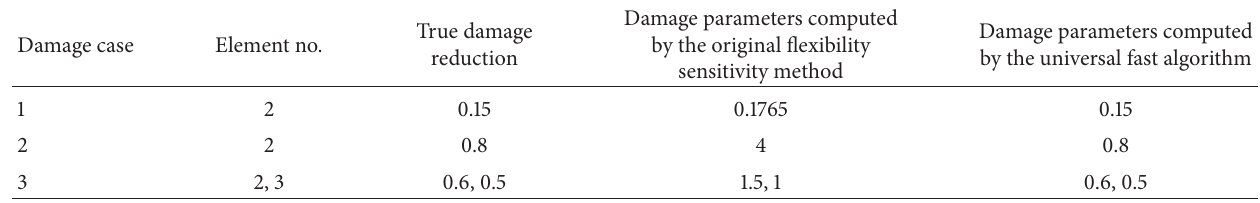
Table 1: Comparisons of the estimated damage parameters by the original flexibility sensitivity method and the fast algorithm (Example 1).